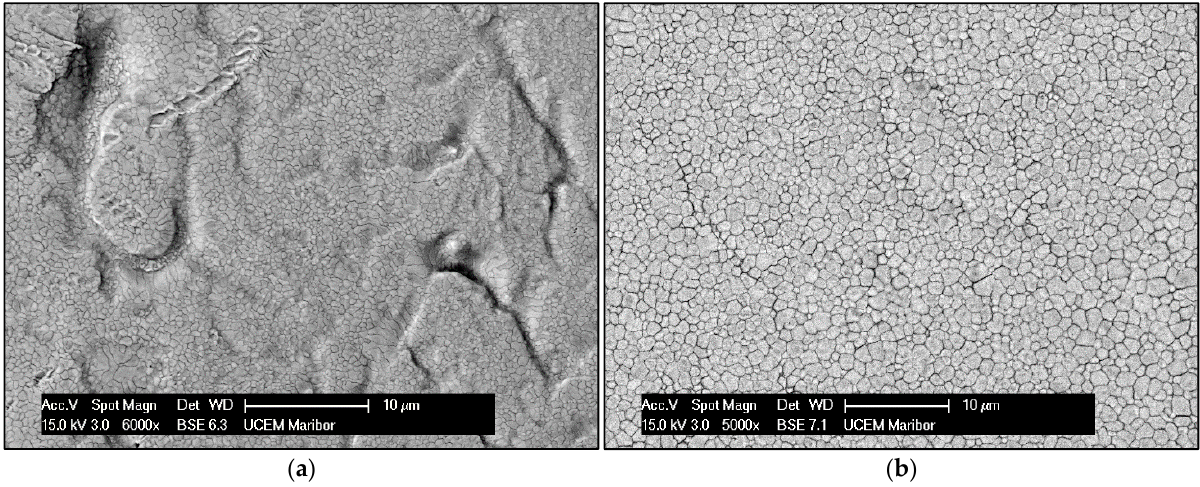
Figure 1. SEM analysis of a rapidly solidified ribbon: ( a ) lower side (wheel surface) of a ribbon with dimples in the surface; ( b ) upper side (free surface) of a ribbon.